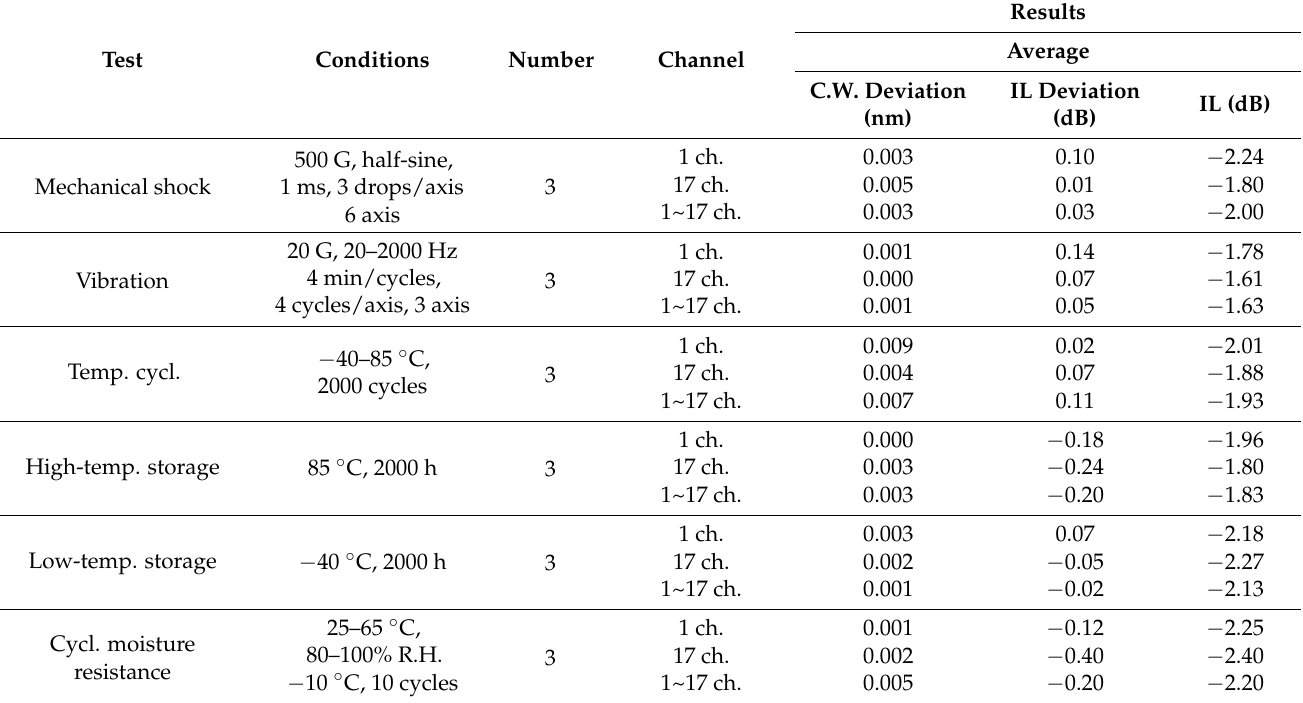
Table 2. Results of reliability